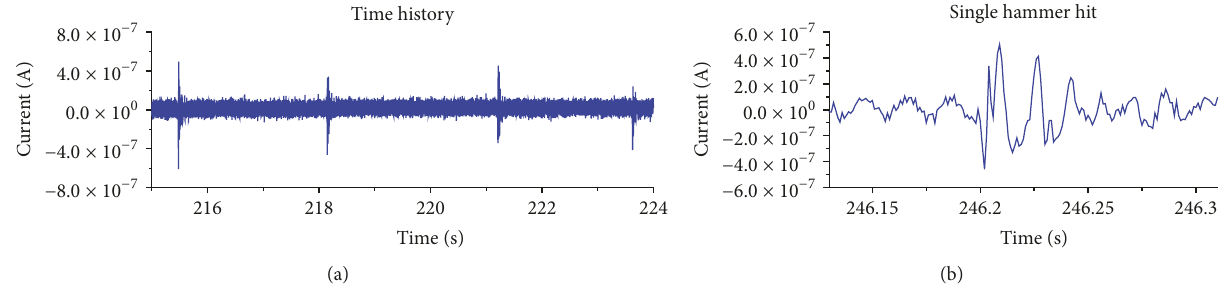
Figure 12: Section of the time history of the current during vibration tests (a) and detailed view of the output of a single hammer hit (b).